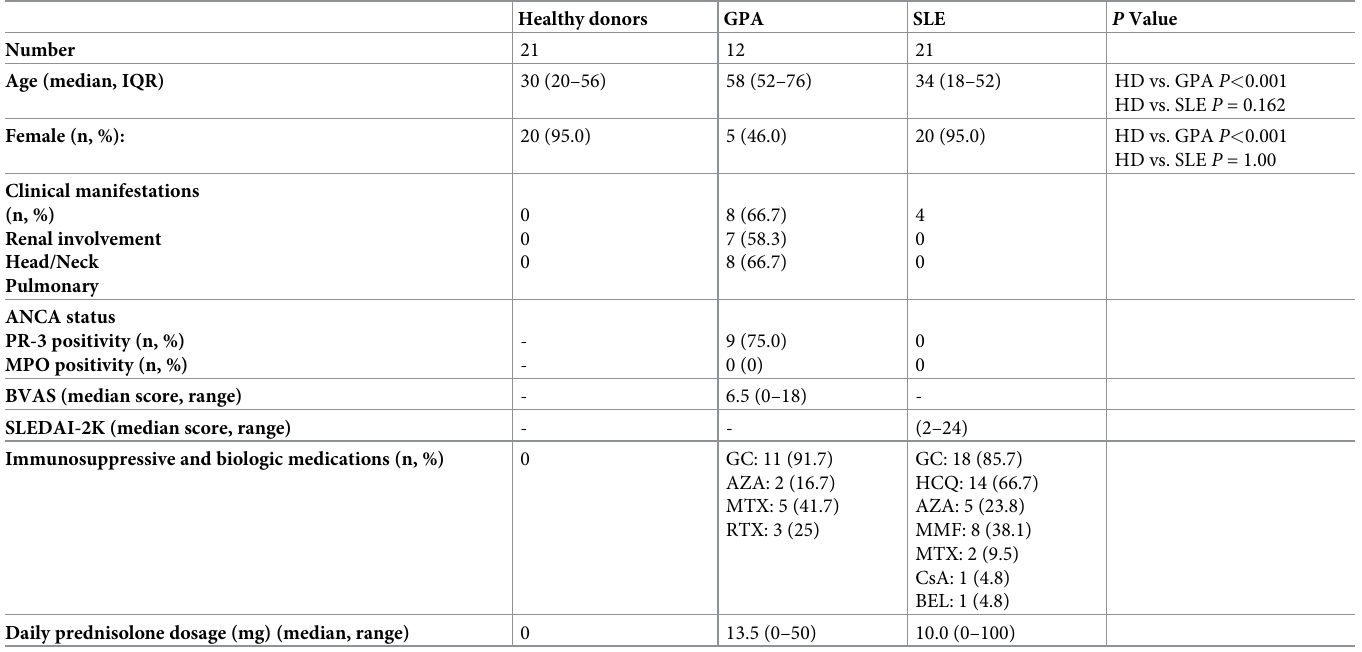
Table 1. Patient characteristics.